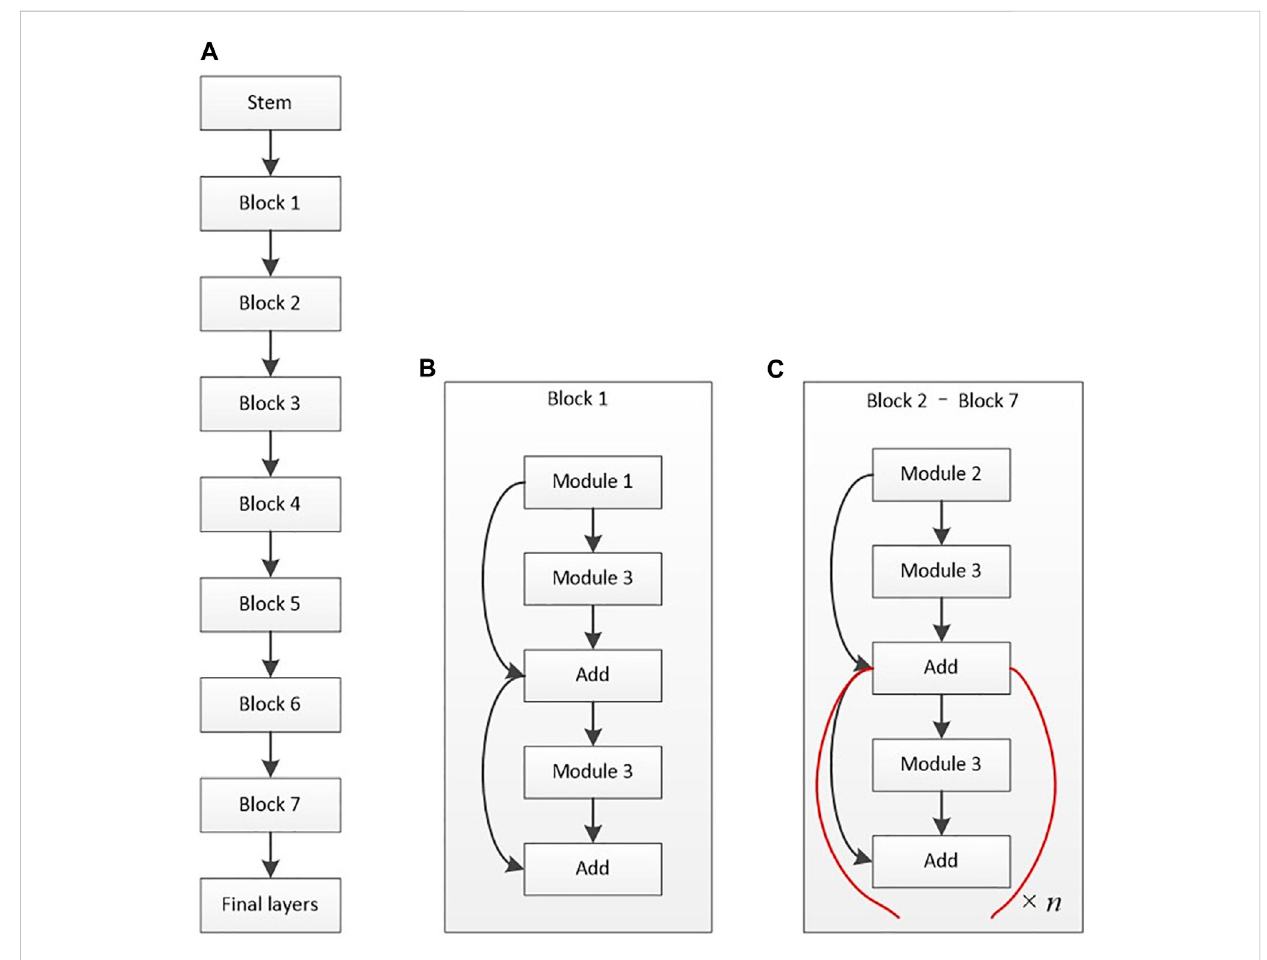
FIGURE 2 Architectural diagram of Ef fi cientNet-B6 (Xu W. et al., 2021). (A) Basic architecture. (B) Structure of block 1. (C) Structure of blocks 2 – 7.